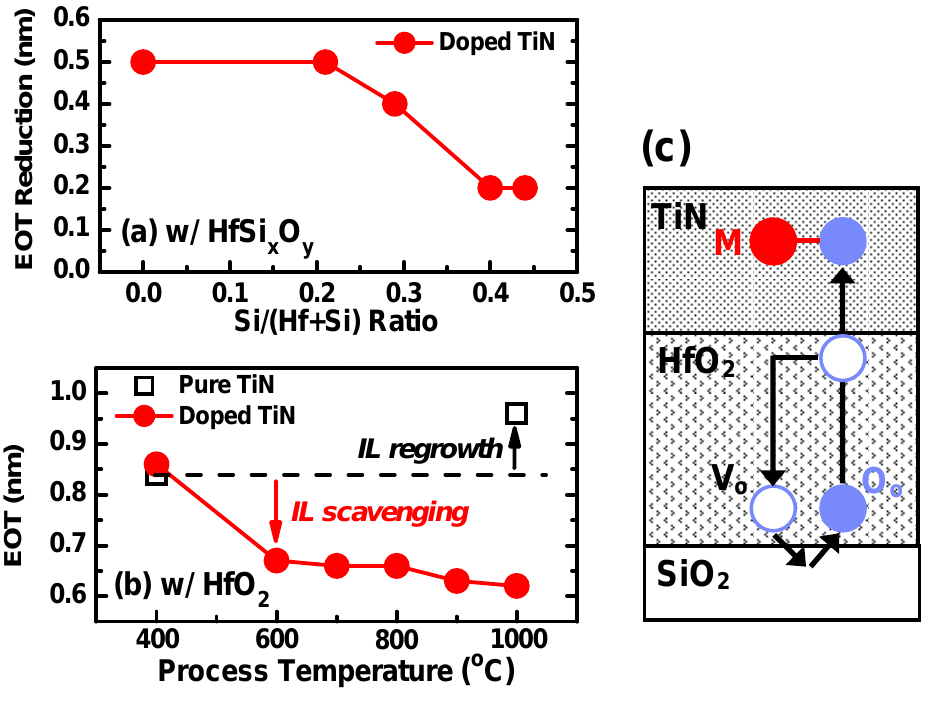
Figure 5. ( a ) EOT reduction via remote-scavenging from doped TiN electrodes as a function of Si/(Hf+Si) ratio in HfSi O gate dielectrics. The EOT reduction is calculated x y from the difference between the doped TiN and the pure TiN; ( b ) EOT as a function of maximum process temperature for doped TiN and pure TiN using HfO gate dielectrics 2 (after [34]); ( c ) Schematics of remote scavenging reaction. M, V , and O represent the 0 0 scavenging element, the oxygen vacancy in HfO , and the oxygen atom in the lattice 2 position of HfO , 2